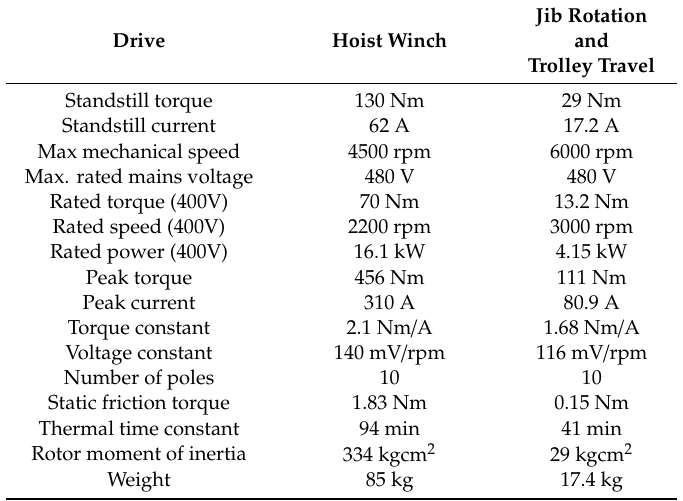
Table 1. The parameters of permanent-magnet motors for crane prototype.